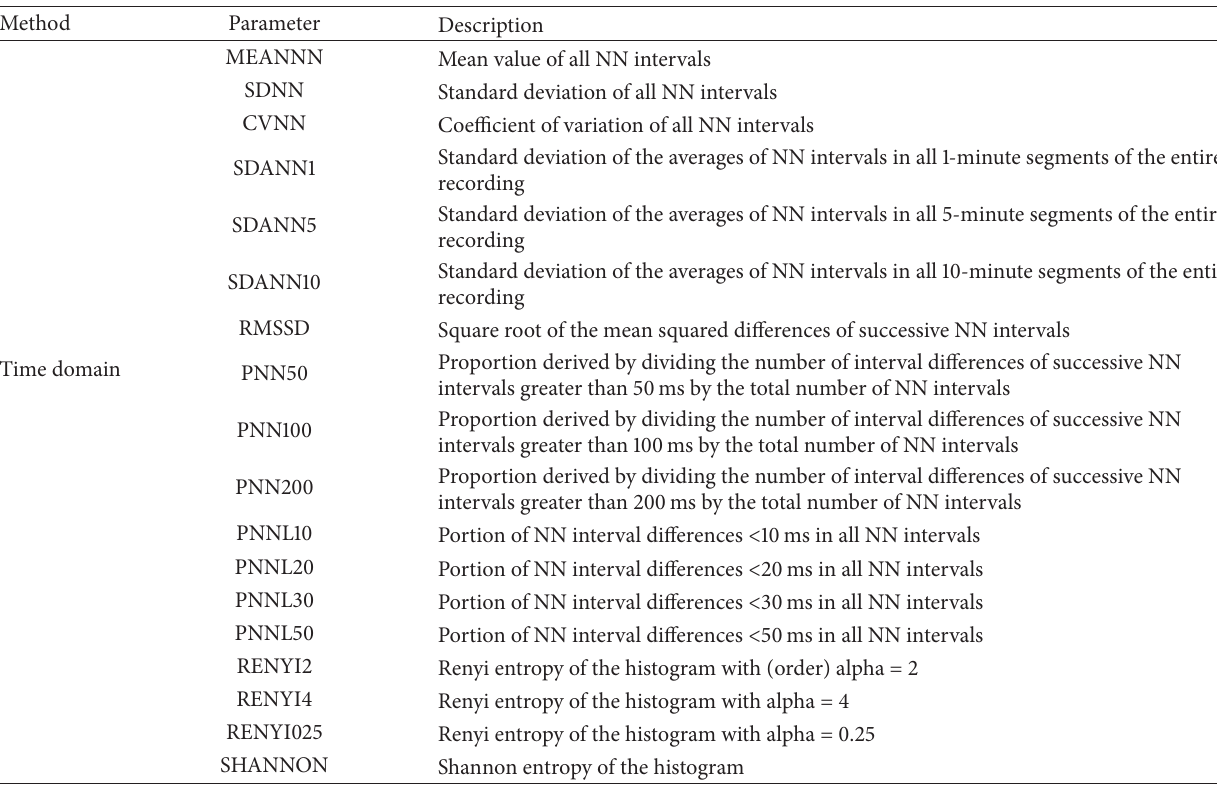
Table 1: Description of parameters calculated by time domain analysis. Parameters were calculated for heart rate and systolic and diastolic blood pressure.